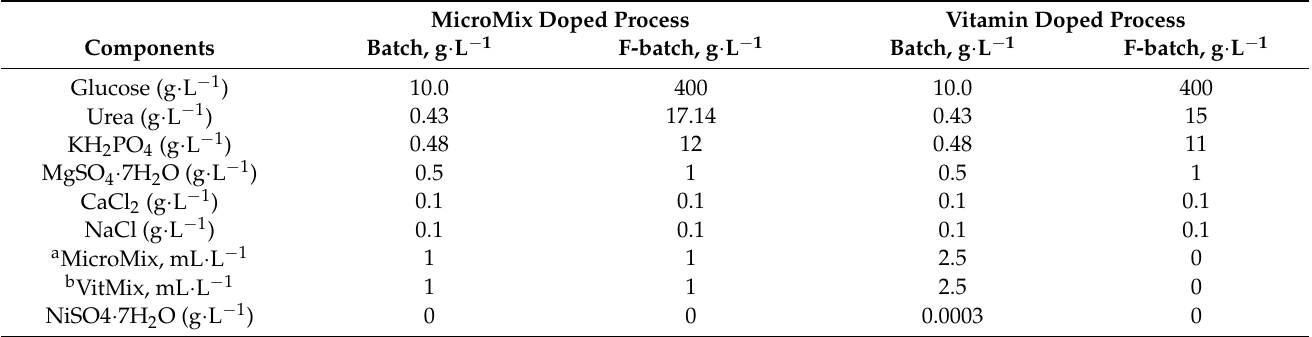
Figure A3. K. marxianus (vitamin and Ni 2+ doped) bioreactor fed-batch cultivation. Tests of biomass growth response to individual vitamin and Ni 2+ addition. Table A1. Cultivation medium and feeding solution